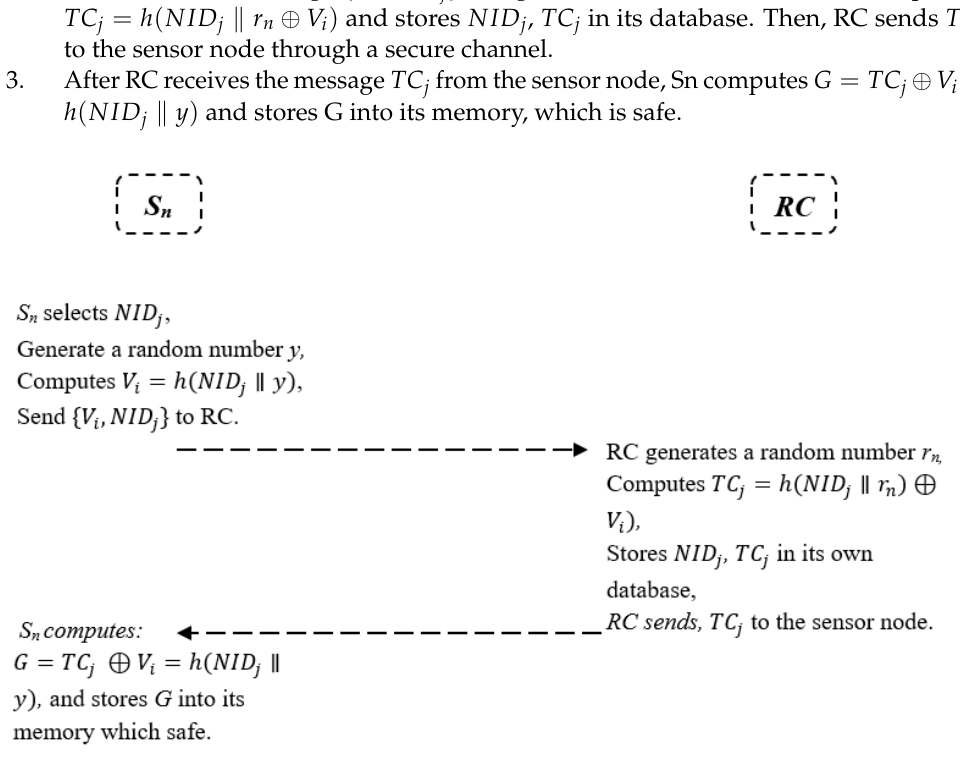
Figure 4. Sensor node registration